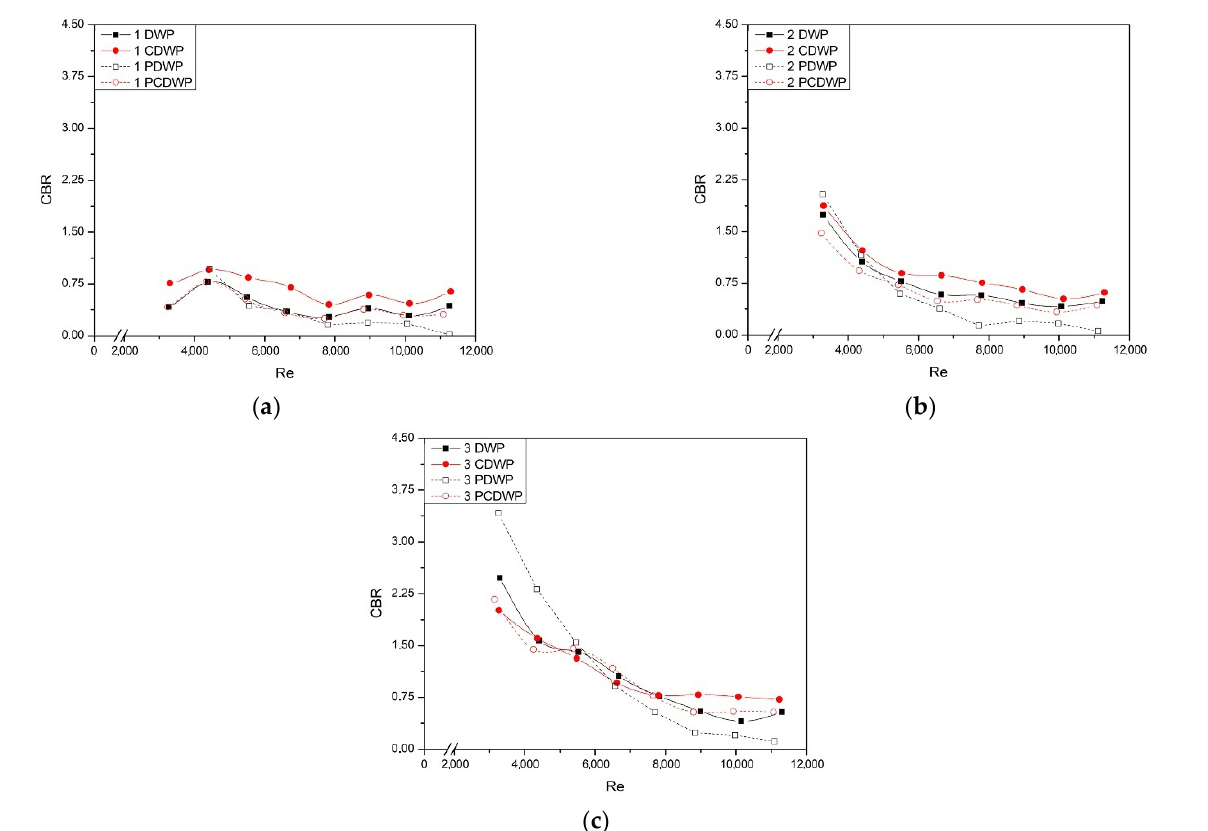
Figure 7. CBR showing the effect of the use of VG with/without holes on the variation in the Reynolds numbers and the number of pairs of VGs. ( a ) One pair of VG, ( b ) Two pairs of VG, and ( c ) Three pairs of VG.